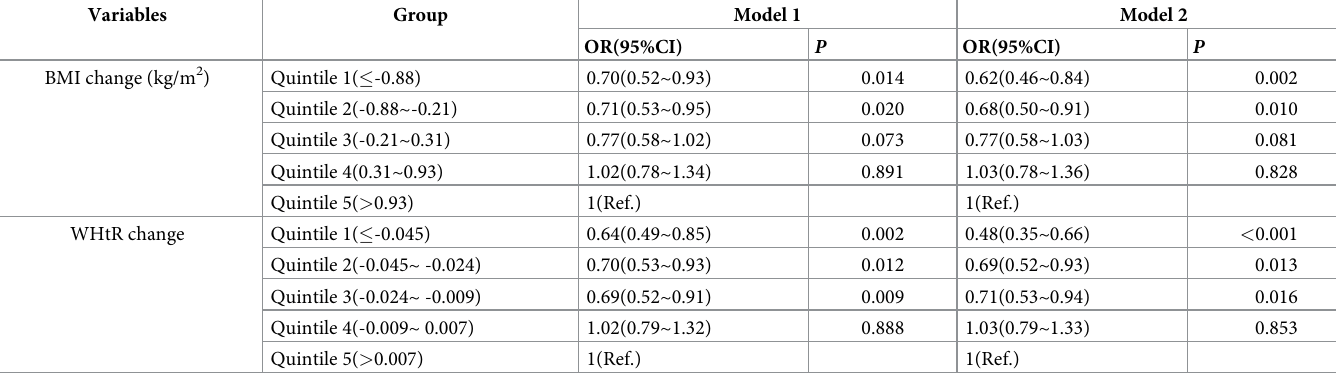
Table 4. Association between risk of high blood pressure and different quintile of BMI or WHtR change in the obese children.